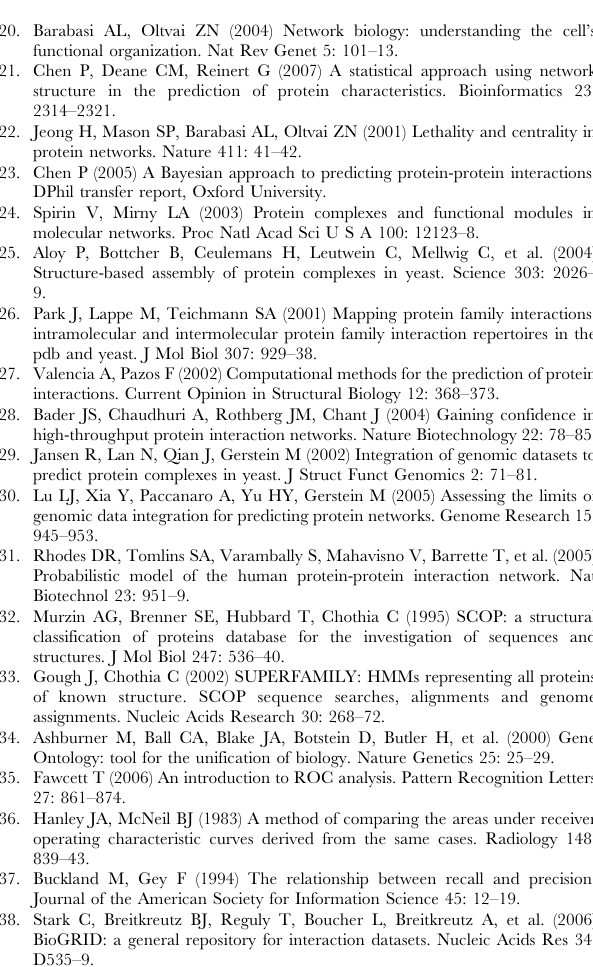
Table S3 List of 7 classes in SCOP